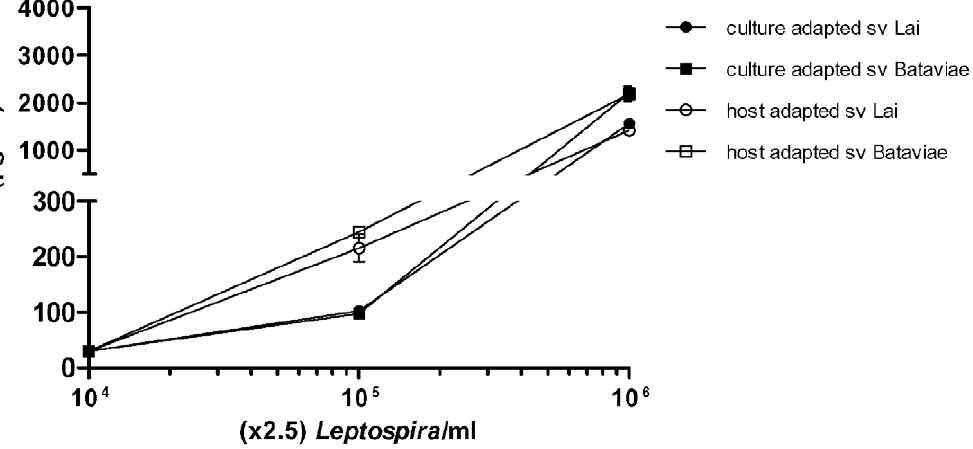
Figure 4. Activation of whole blood with live leptospires. Whole blood was stimulated for 6 h with varying concentrations of leptospires. TNF- a concentrations were measured from cell culture supernatants. Data represent the mean values and error bars represent the standard deviation (SD) of the mean. The response of all blanks was below the baseline and therefore is not shown.